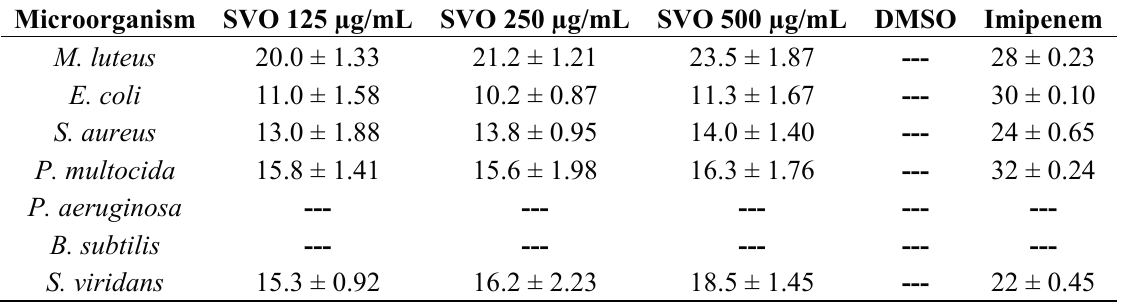
Table 2. Antibacterial effects of the essential oil of the leaves of Skimmia laureola (SVO).